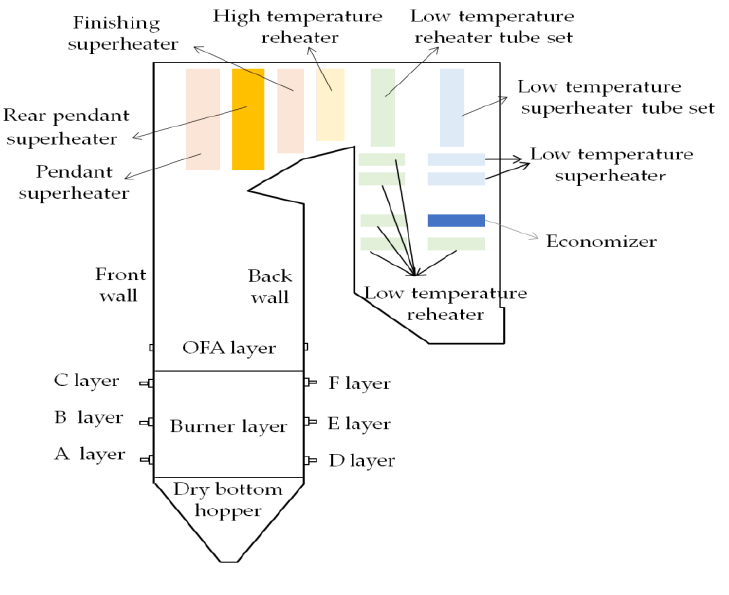
Figure 2. Boiler